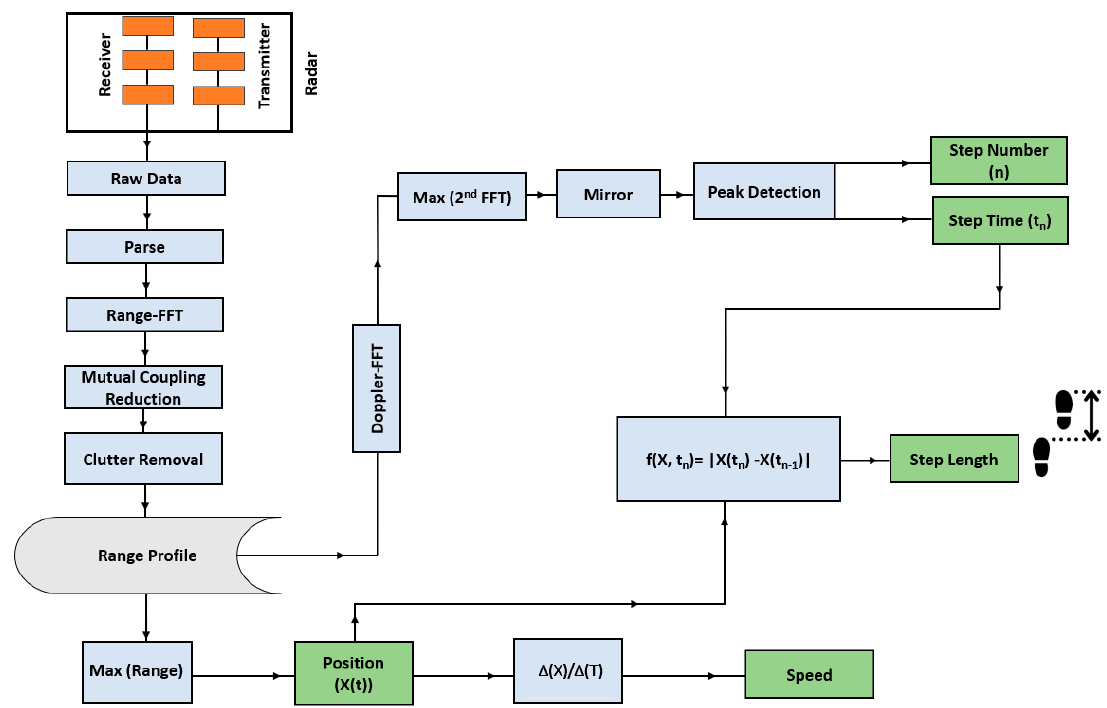
Figure 4. Proposed gait extraction algorithm (adapted from [11]).